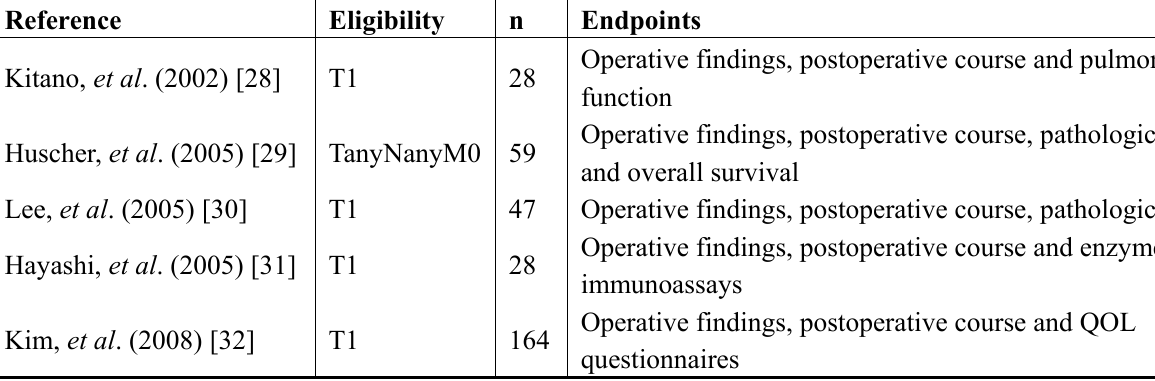
Table 1. Randomized controlled trial of laparoscopic